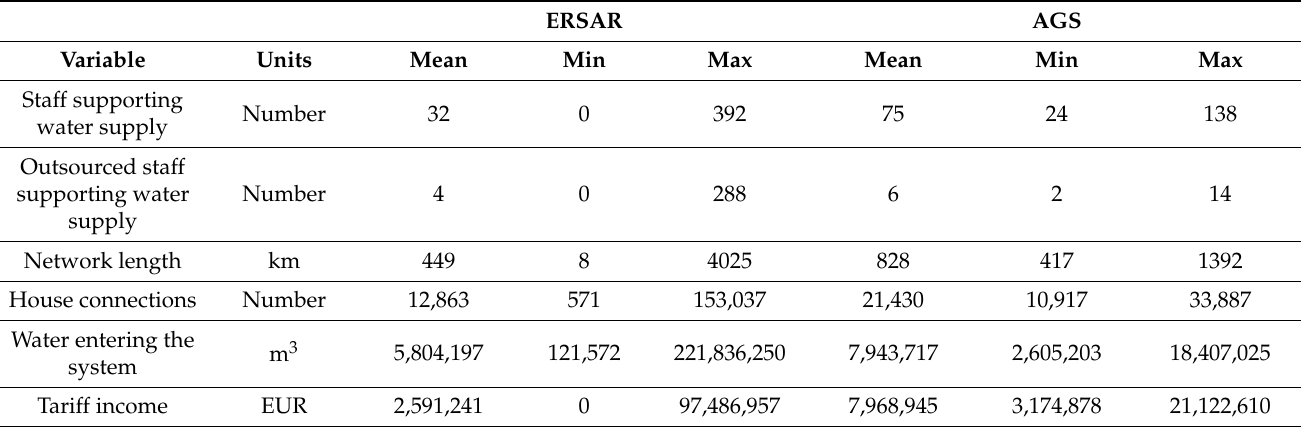
Table 3. General characteristics of all Portuguese retail water utilities and AGS’ water utilities (all retail). Obtained for 2019 from